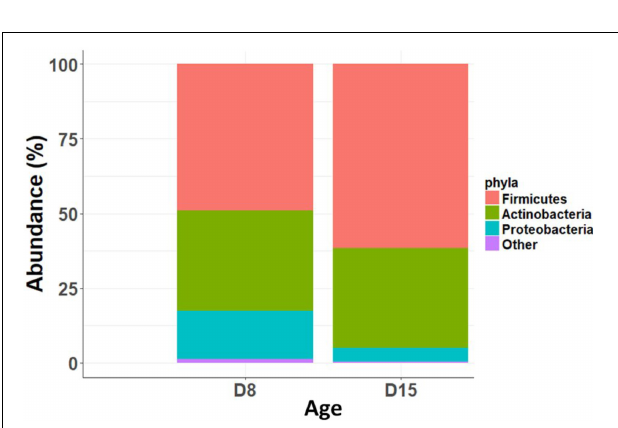
FIGURE 2 | Relative abundance of main bacterial phyla at D8 and